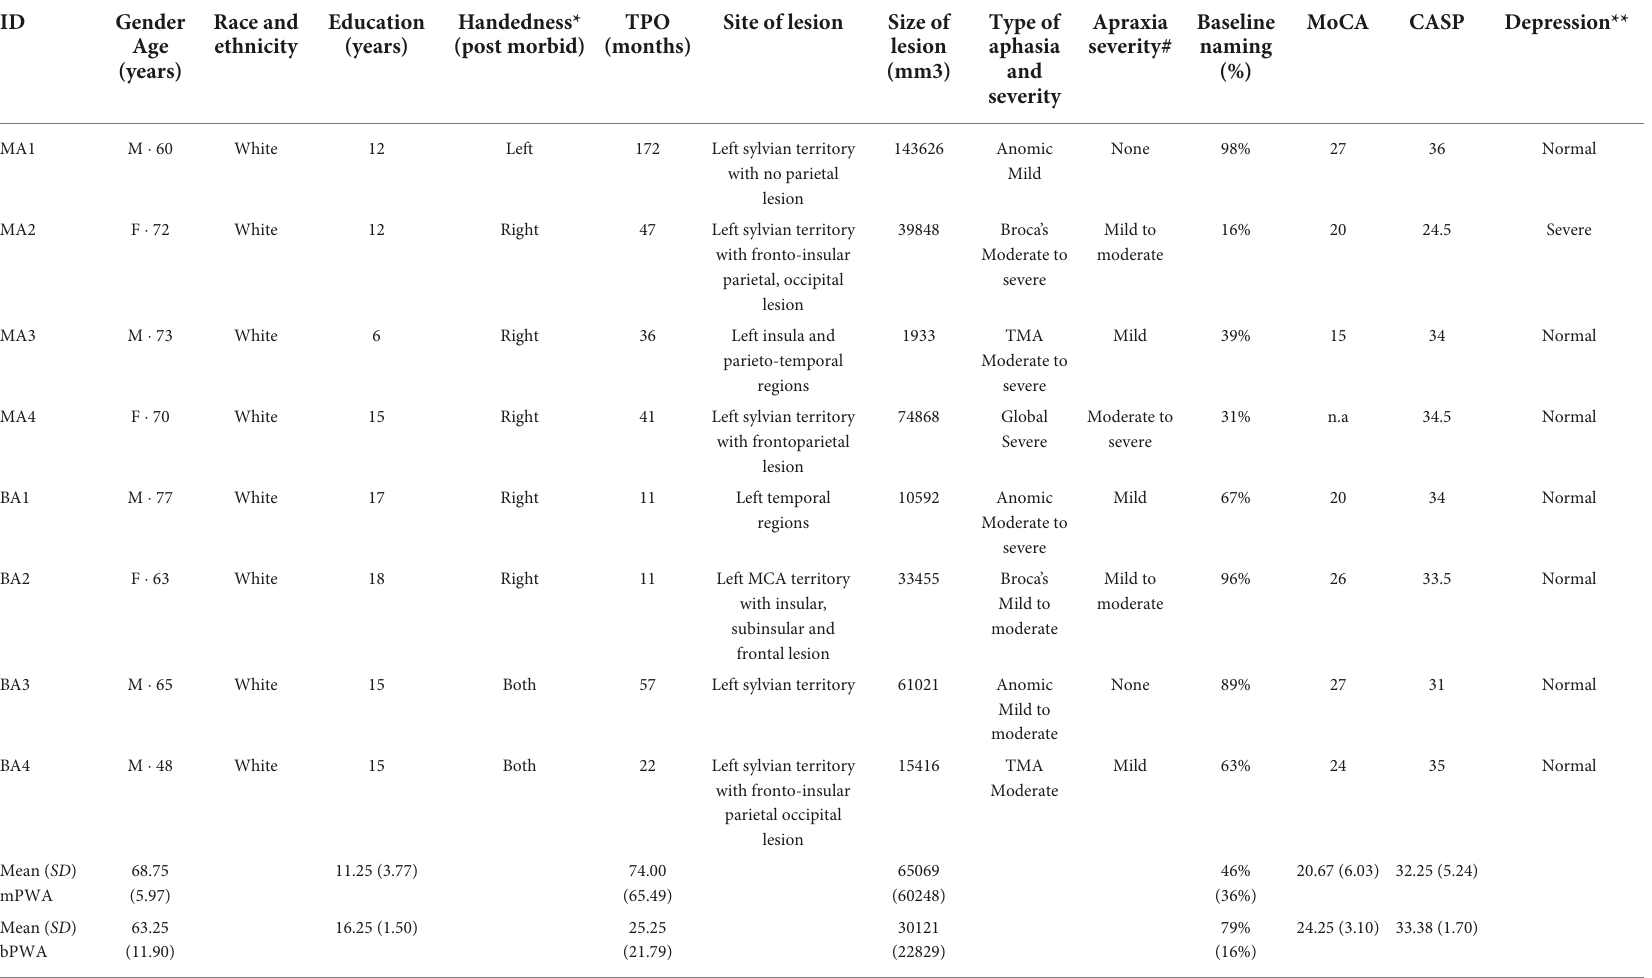
TABLE 1 Demographic information, clinical data, and standardized neuropsychological background test scores of participants with